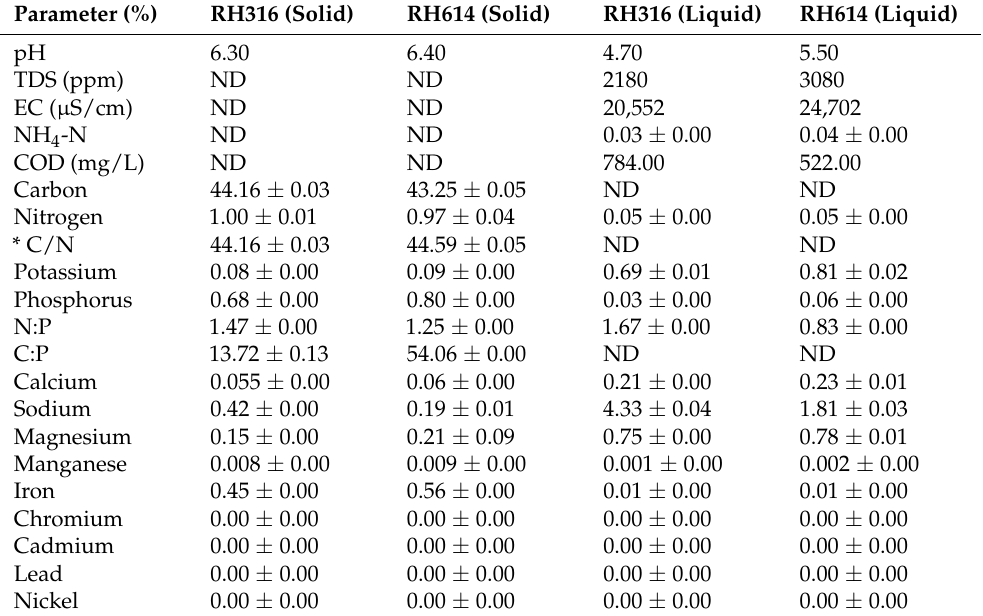
Table 2. Physicochemical properties of liquid and solid